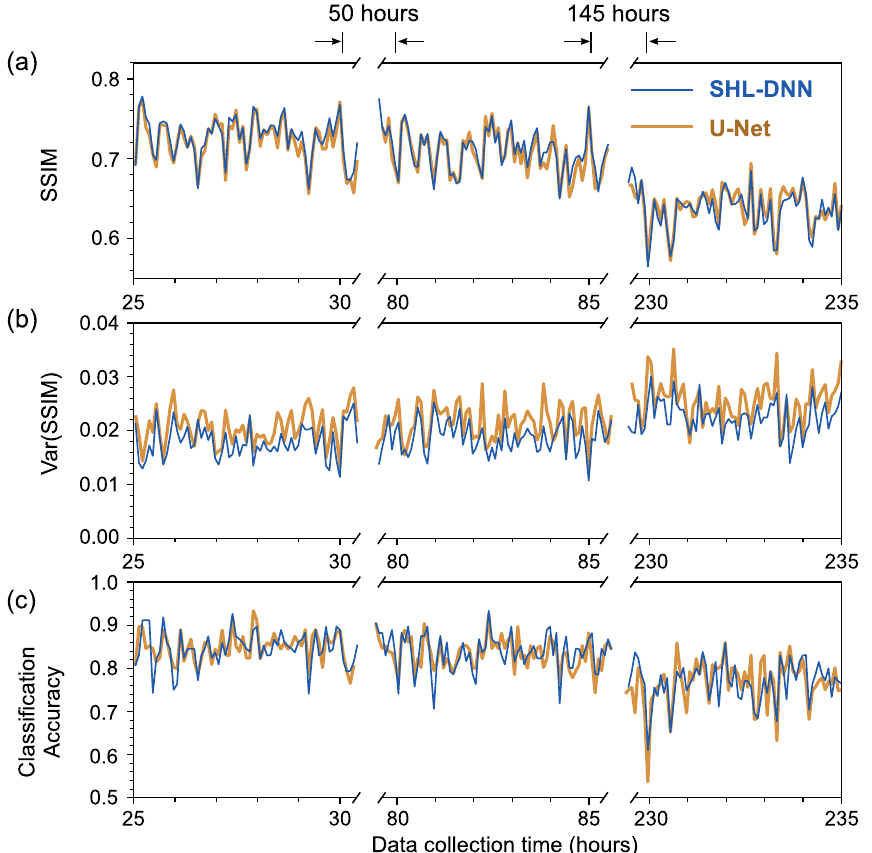
Figure 4. MMF image reconstruction metrics using data collected at different times subsequent to the training set. The SHL-DNN and U-Net are trained using 27685 images collected over 19 h, and then validated against images collected over the subsequent 235 h. The time axis is divided into 5 minute bins with 137 validation images per bin. ( a ) SSIM. ( b ) Variance of SSIM, corresponding to the spread of the SSIM in each 5 minute bin. ( c ) Classification accuracy, obtained by feeding the output images from each neural network into an auxiliary high-accuracy